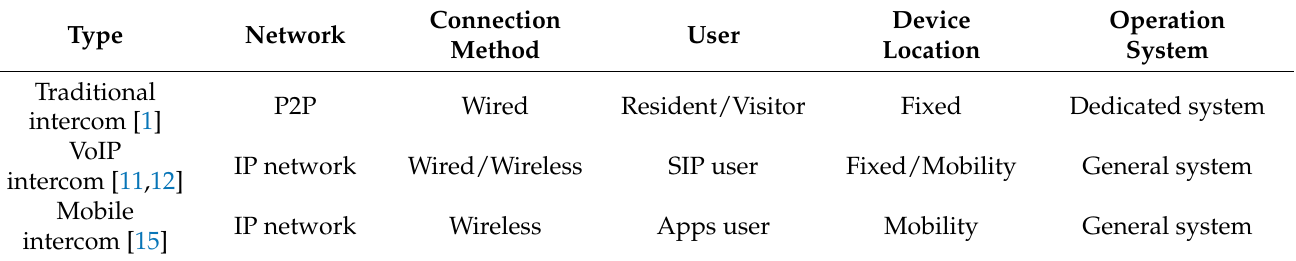
Table 1. Comparison list of the properties of three types of